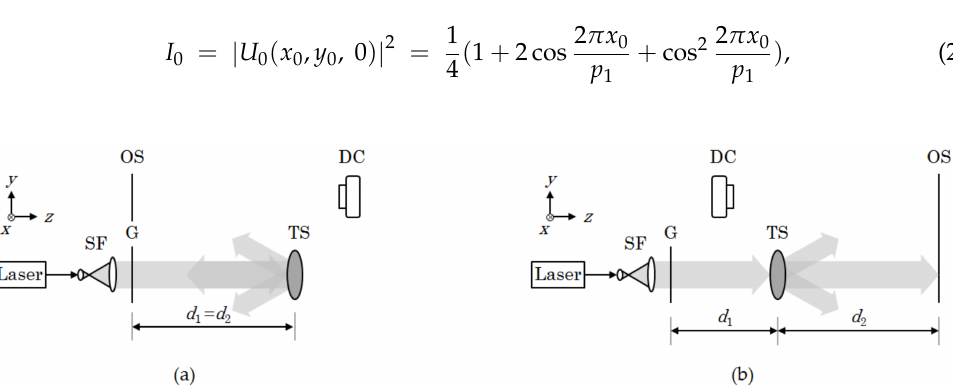
Figure 1. Schematic of the measurement setup for ( a ) reflection and ( b ) transmission samples. SF, spatial light filter; G, Ronchi grating; TS, test sample; OS, observation screen; DC, digital